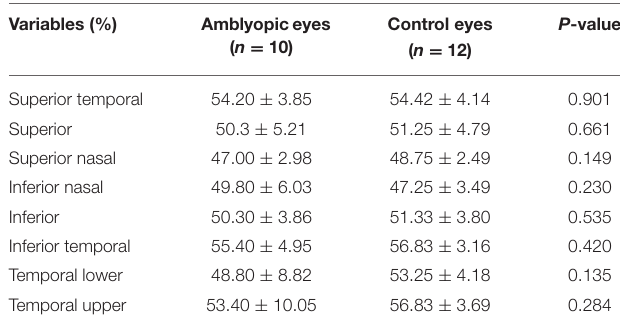
TABLE 6 | Eight-sector peripapillary capillary small vessel density in amblyopic and control